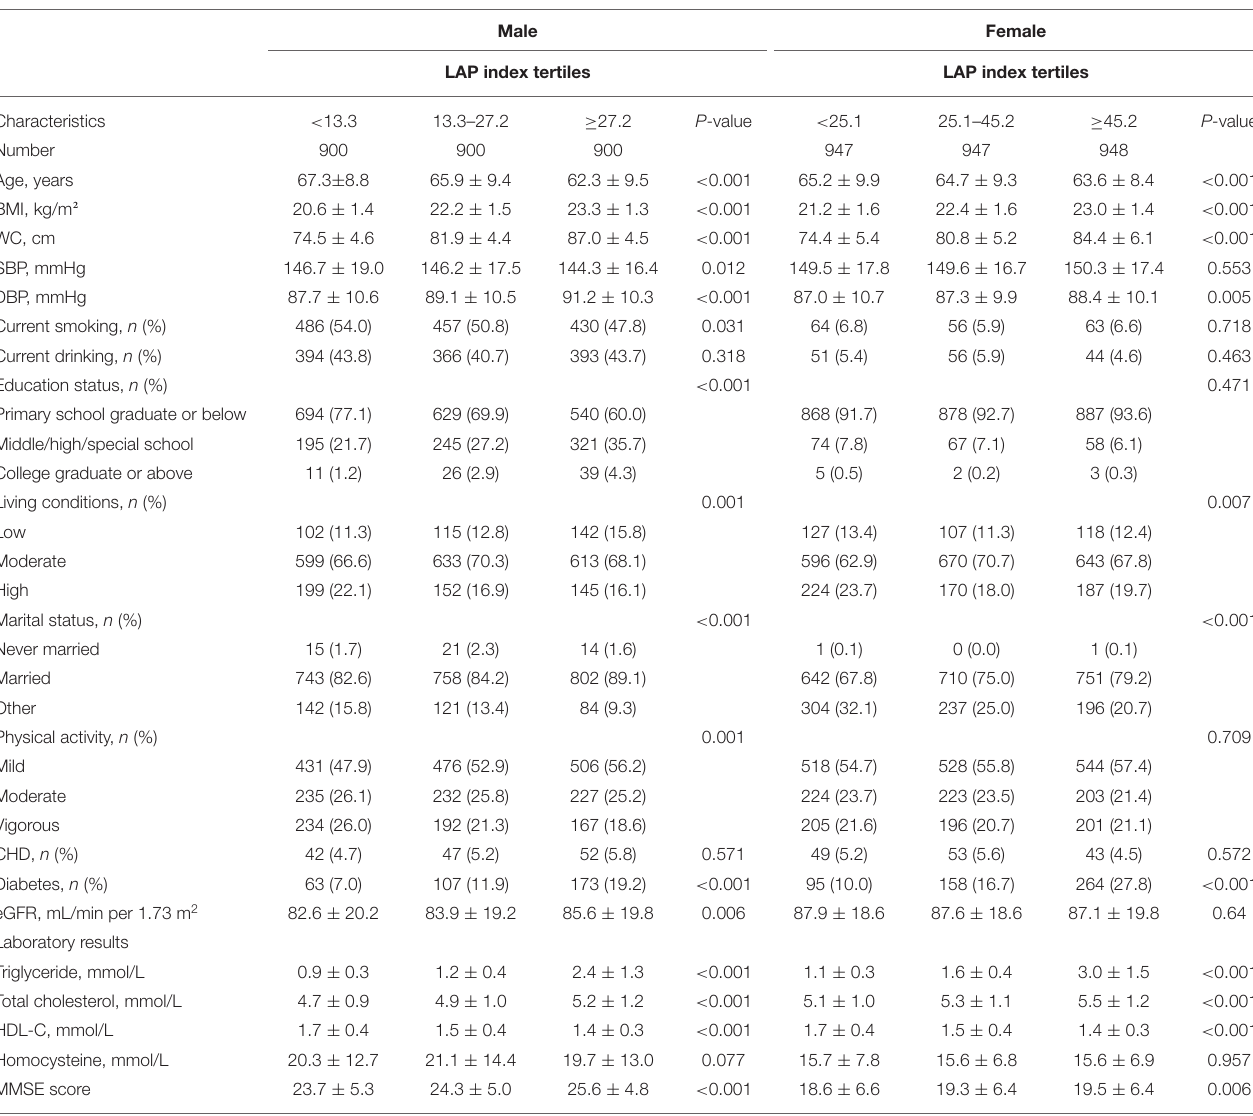
TABLE 1 | Baseline characteristics of study